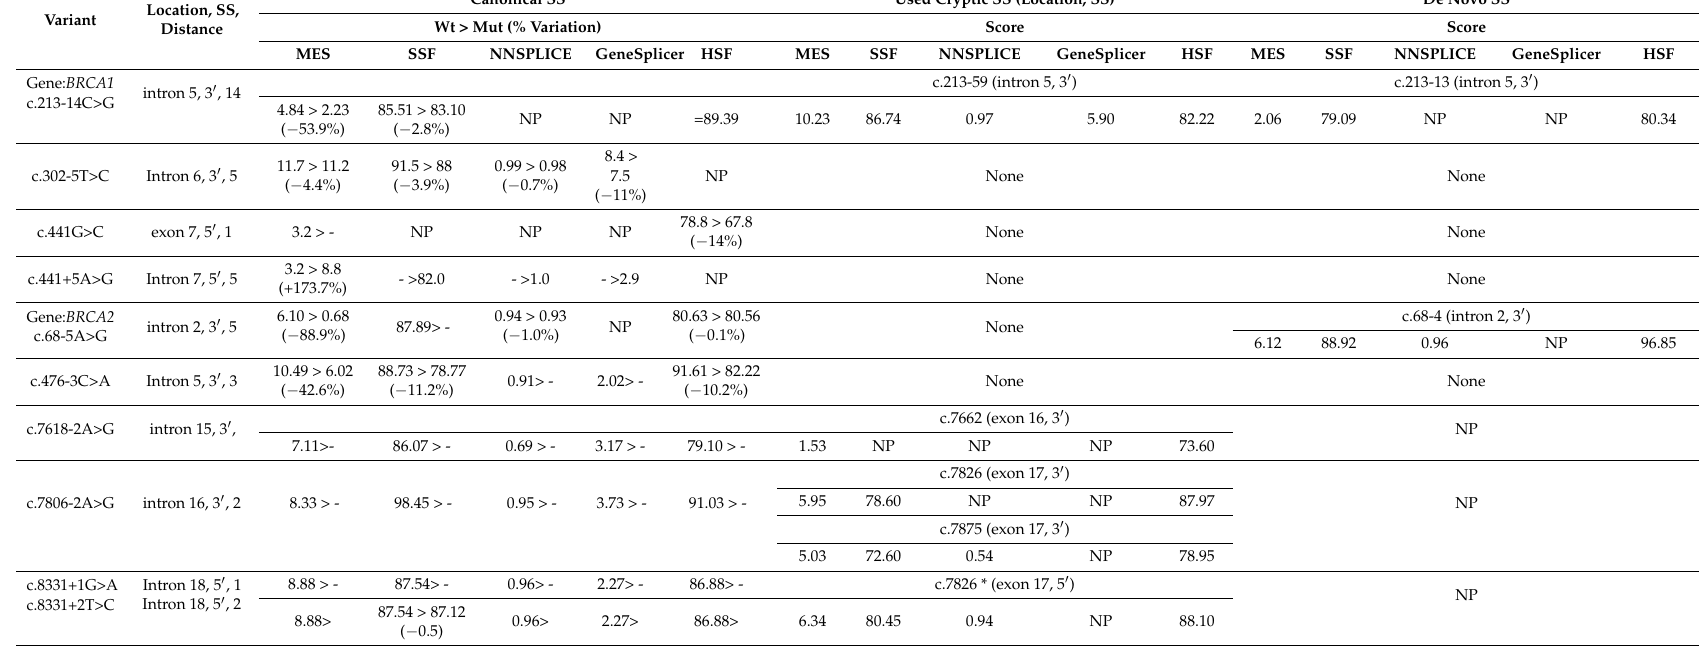
Table 2. In silico analyses for variants leading to the usage of cryptic/de novo splice